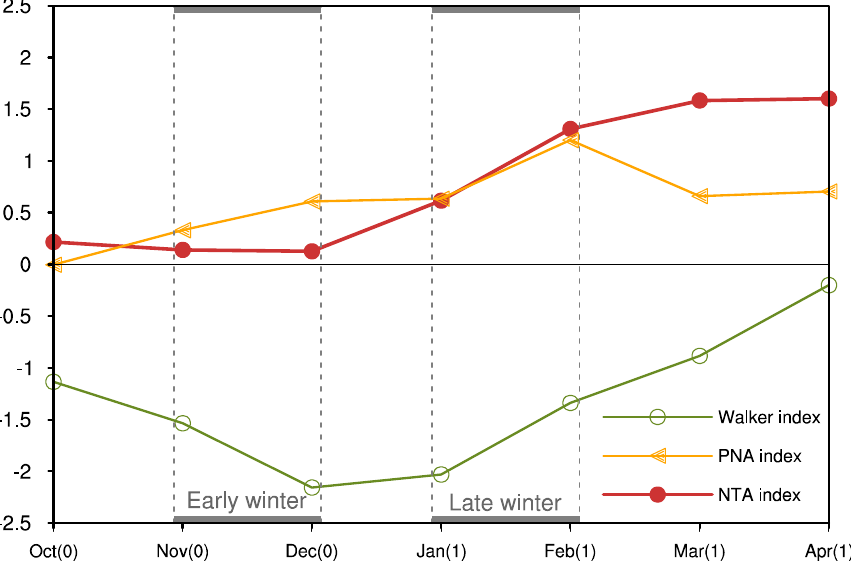
Figure 7. Monthly evolution of difference of the standardized Walker index (green line), PNA index (orange line), and NTA index (red line) between composite El Niño and La Niña.